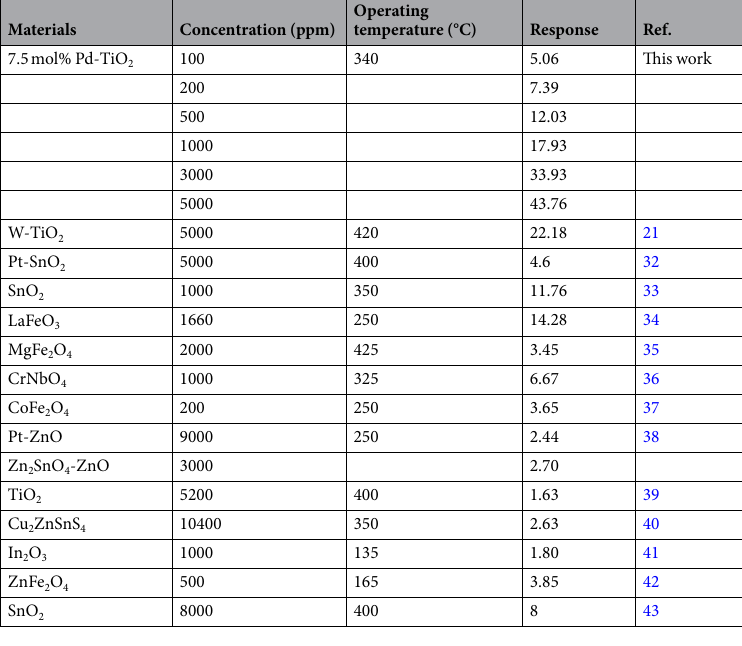
Table 1. Comparison of varied material nanostructures in butane sensing performances.